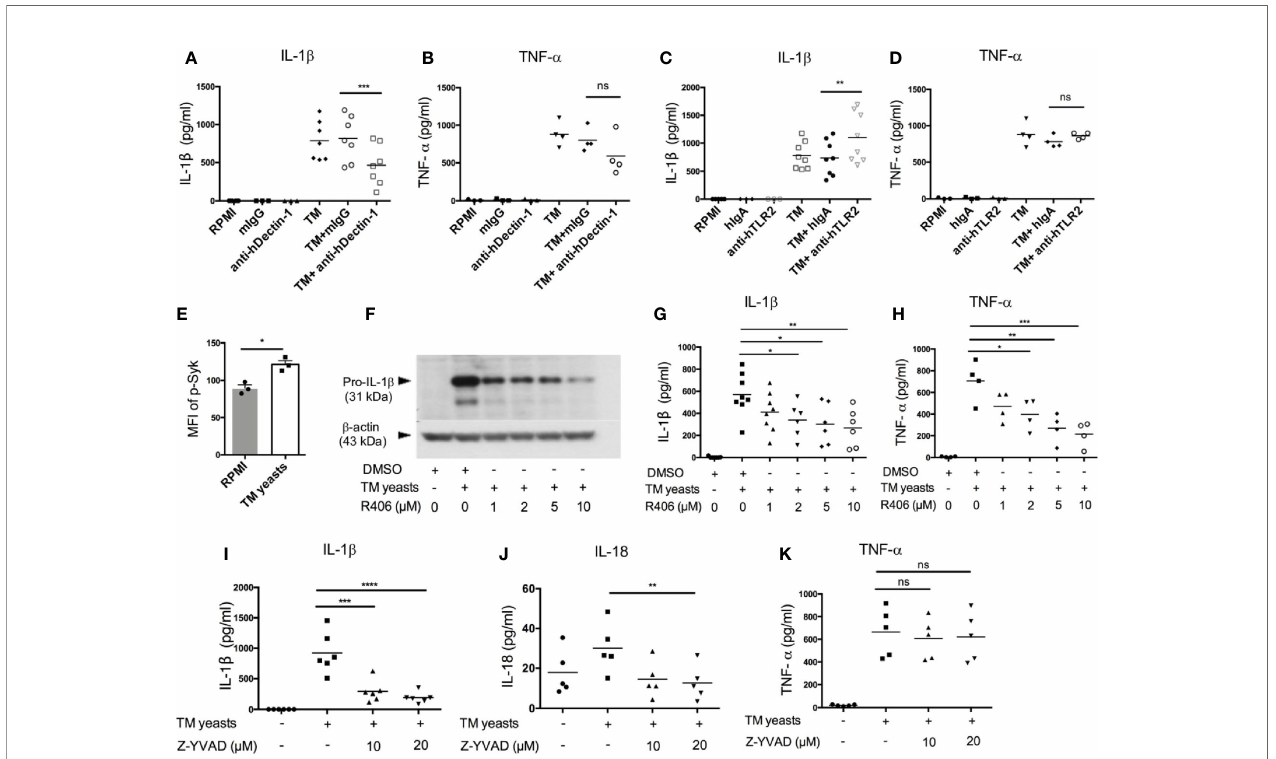
FIGURE 3 | Dectin-1/Syk signaling mediates IL-1 b response to T. marneffei yeasts in human monocytes. (A, B) Quanti fi cation of IL-1 b and TNF- a by ELISA in human CD14 + monocytes (2x10 6 /ml) stimulated with heat-killed T. marneffei (TM) yeasts (0.5 MOI) for 18 hr in the presence of anti-hDectin-1 blocking antibodies or mouse IgG (mIgG) (10 m g/ml). (C, D) Quanti fi cation of IL-1 b and TNF- a by ELISA in human CD14 + monocytes (2x10 6 /ml) stimulated with heat-killed T. marneffei (TM) yeasts (0.5 MOI) for 18 hr in the presence of anti-hTLR2 blocking antibodies or human IgA (hIgA) (10 m g/ml). (E) Detection of median fl uorescence intensity (MFI) of phospho-Syk by fl ow cytometry in human CD14 + monocytes (2x10 6 /ml) stimulated with heat-killed T. marneffei (TM) yeasts (0.5 MOI) for 18 hr (n=3, mean ± SEM). (F) A representative immunoblot of pro-IL- b of cell lysates in human CD14 + monocytes (2x10 6 /ml) stimulated with heat-killed T. marneffei (TM) yeasts (0.5 MOI) for 18 hr in the absence or presence of Syk inhibitor, R406 (n=3). (G, H) ELISA quanti fi cation of IL-1 b and TNF- a in the culture supernatant of human CD14 + monocytes (2x10 6 /ml) stimulated with heat-killed T. marneffei (TM) yeasts (0.5 MOI) for 18 hr in the absence or presence of Syk inhibitor, R406. (I ‒ K) Quanti fi cation of IL-1 b , IL-18 and TNF- a by ELISA in the culture supernatant of human CD14 + monocytes (2x10 6 /ml) stimulated with heat-killed T. marneffei yeasts (0.5 MOI) for 18 hr in the absence or presence of Z-YVAD (caspase-1 inhibitor). Data are analyzed by paired two-tailed t test (A ‒ E) or by one-way ANOVA (G-K). Each symbol represents one healthy donor. ns, not signi fi cant, *p < 0.05, **p < 0.01, ***p < 0.001, ****p <